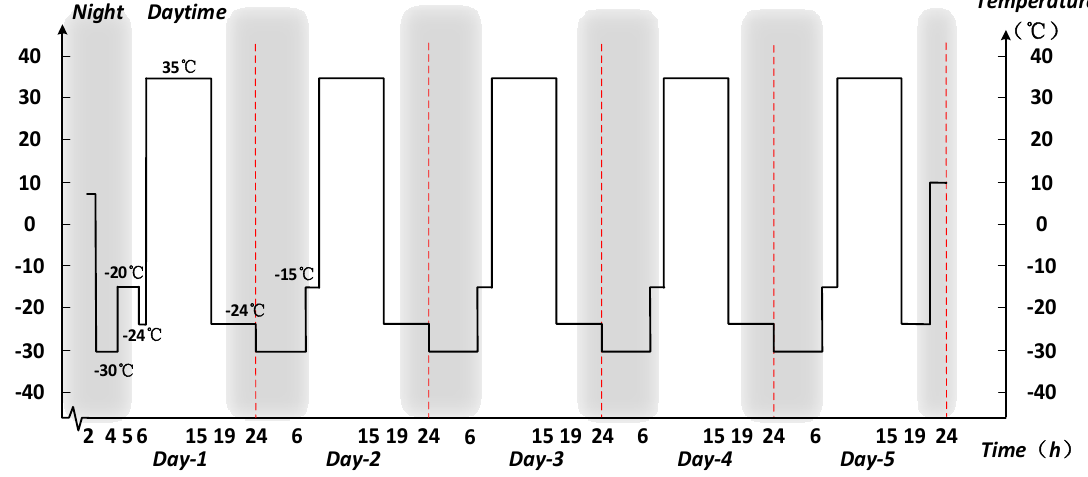
Figure 14. Simplified temperature profile of solar-powered UAV flight.